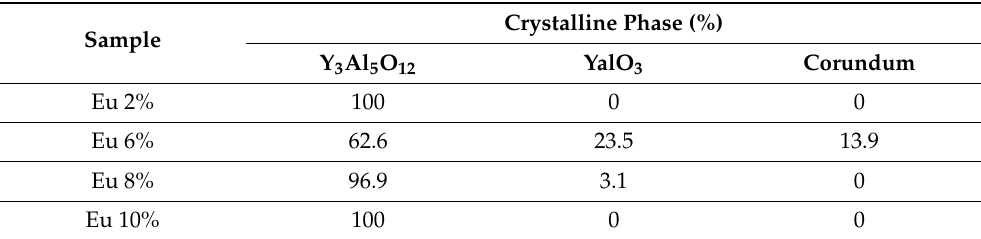
Table 1. The quantitative analysis of the YAG samples doped with di ff erent concentrations of euro- pium.